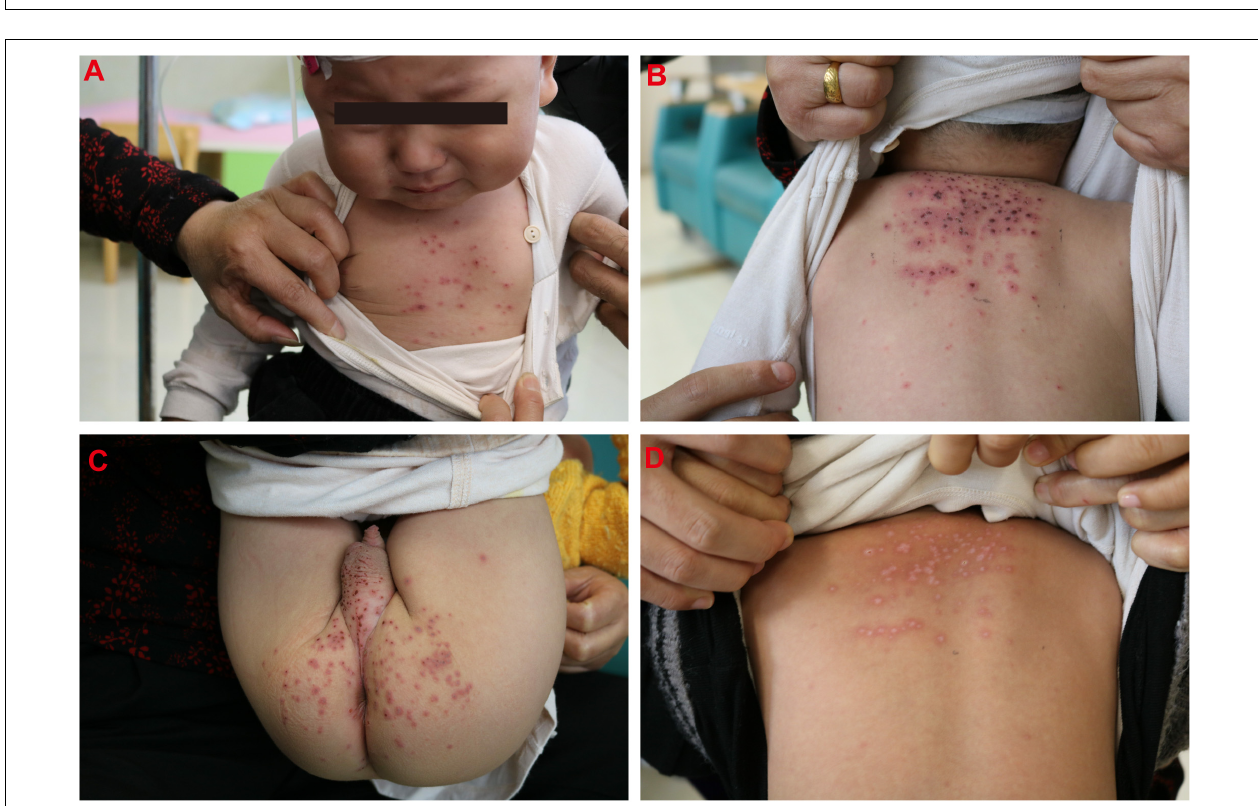
FIGURE 2 | Rash on chest (A) , back (B) , and hip (C) in the boy (case 1). (D) A photograph of back showing the rash had